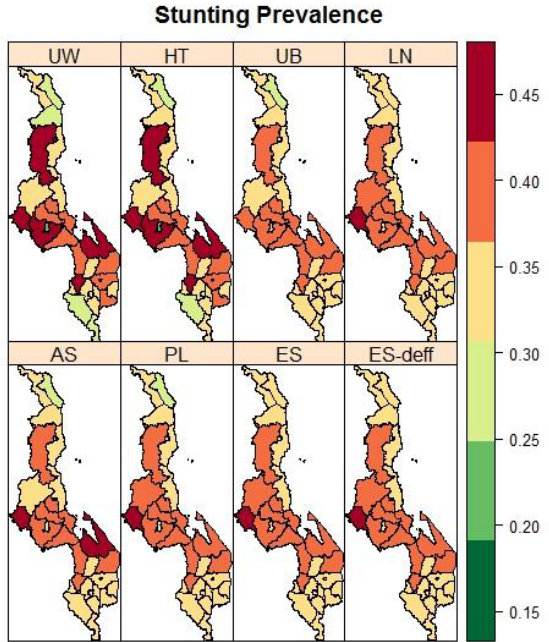
Figure 2. Maps of the observed (UW: Unweighted, HT: Horvitz – Thompson) and spatial estimated prevalences of stunting (UB: Unadjusted Binomial estimator (Model 1), LN: Logit-normal estimator (Model 2), AN: Arcsine-square root transformation estimator (Model 3), PL: Pseudo-likelihood estimator (Model 4), ES: Effective Sample size estimator (Model 5), and ES-deff: Effective Sample size estimator using design effect (Model 6)) by the district in Malawi using 2015-16 MDHS.